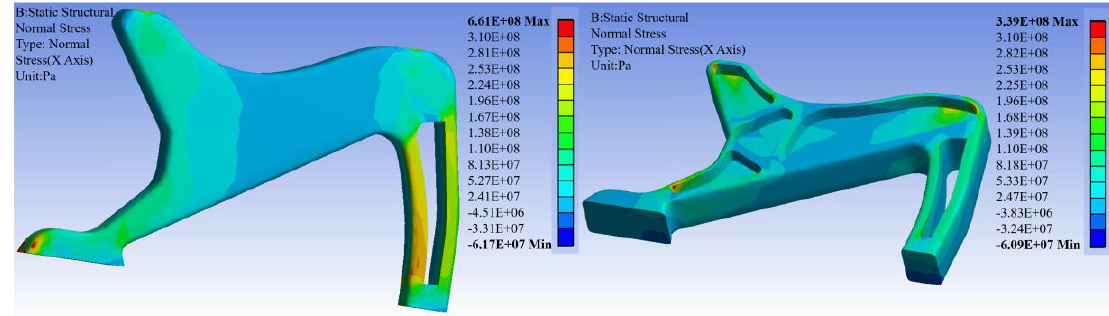
Figure 18. Stress analysis for comparison of the supporting planar plate (maximum principal stress).